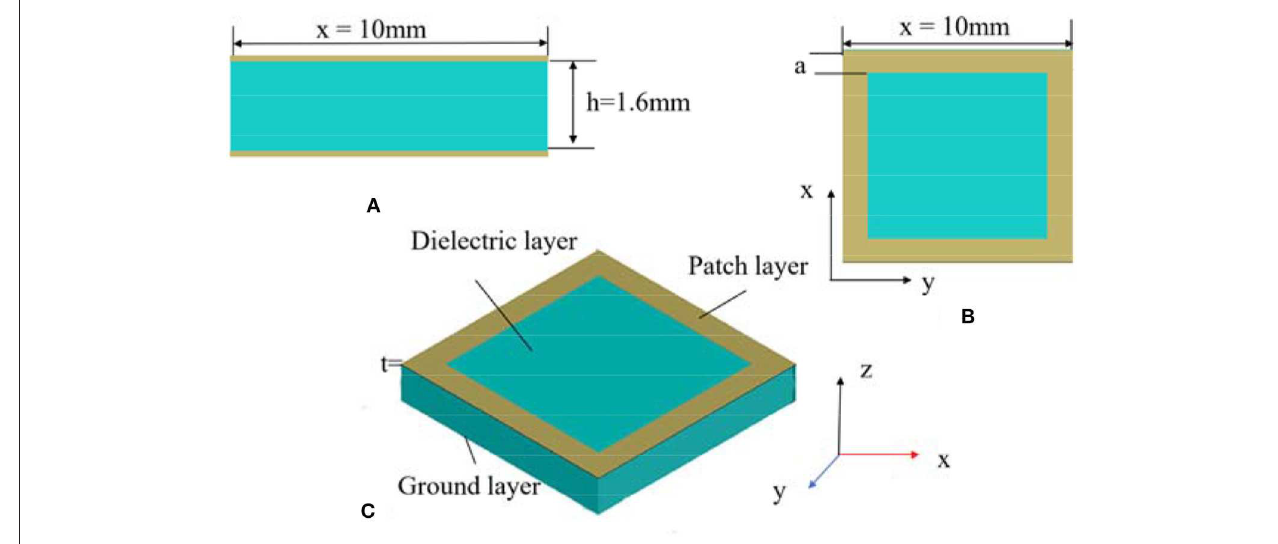
FIGURE 1 | (A) Side view of the three-layer square element, (B) top view, and (C) element parameters.